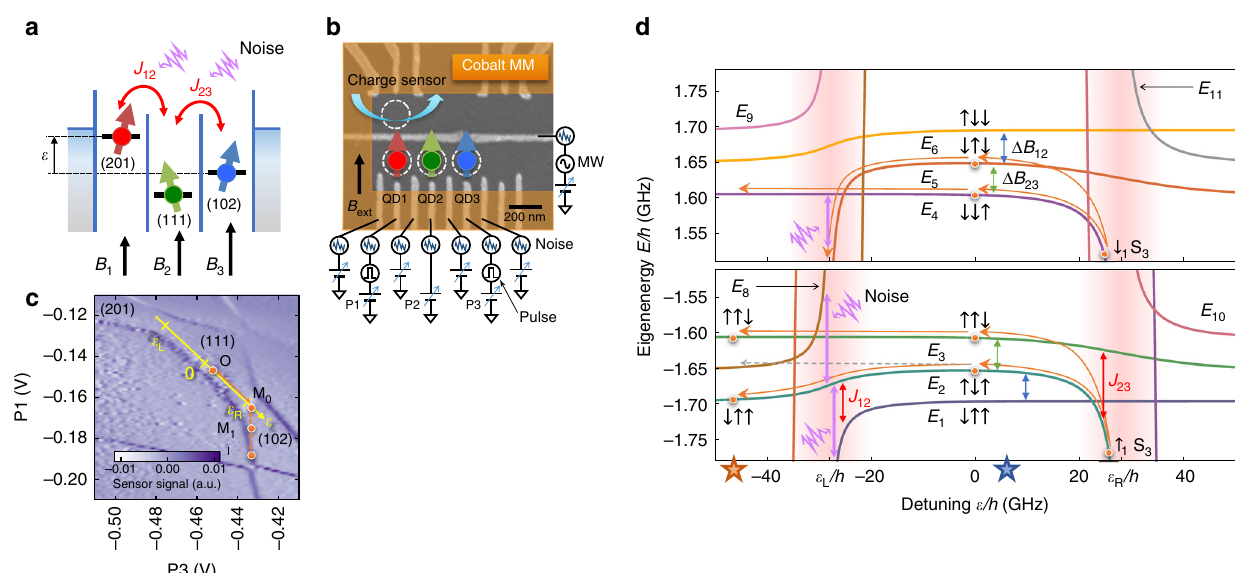
Fig. 2 Experimental implementation of the spin chain. a Schematic of the spin chain with three sites studied in this work. b Schematic of a TQD device similar to the one measured, containing single-electron spins in each QD. The TQD is fabricated in a GaAs/AlGaAs heterostructure. The cobalt micromagnet deposited on a calixarene insulation layer is magnetized by an externally applied in-plane magnetic fi eld of B ext = 0.7 T and it induces a difference of the local Zeeman energy Δ B 12 ( Δ B 23 ) between QD2 and QD1 (QD3 and QD2). The spin states are manipulated by DC gate biases, pulse voltages, microwave signals, and thermal noise applied on fi nger gate structures. c Charge stability diagram of the TQD obtained by differentiating the rf- re fl ectometry signal of the nearby QD charge sensor. The yellow arrow shows the detuning axis along which the potential energy detuning ε between QD1 and QD3 is controlled by gate voltages P1 and P3. The bias points for spin initialization (I), operation (O), and measurements (M 0,1 ) are marked by circles. d Energy diagram of the three-spin states. The Hamiltonian parameters are extracted from the energy spectroscopy in Fig. 4. The energy levels for S z = − 1/ 2 and + 1/2 are shown in the upper and lower panels, respectively (see Supplementary Fig. 3 for the S z = ±3/2 branches). Stars indicate the detuning values at which we measure the coherent evolutions plotted in Fig. (111), voltage pulses are superposed to the gate biases to control the energy offset between charge con fi gurations (102) and (201) along the line shown in Fig. 2c. This allows us to control the detuning energy ε between the left and right QDs while leaving the energy of the (111) con fi guration unchanged. A top